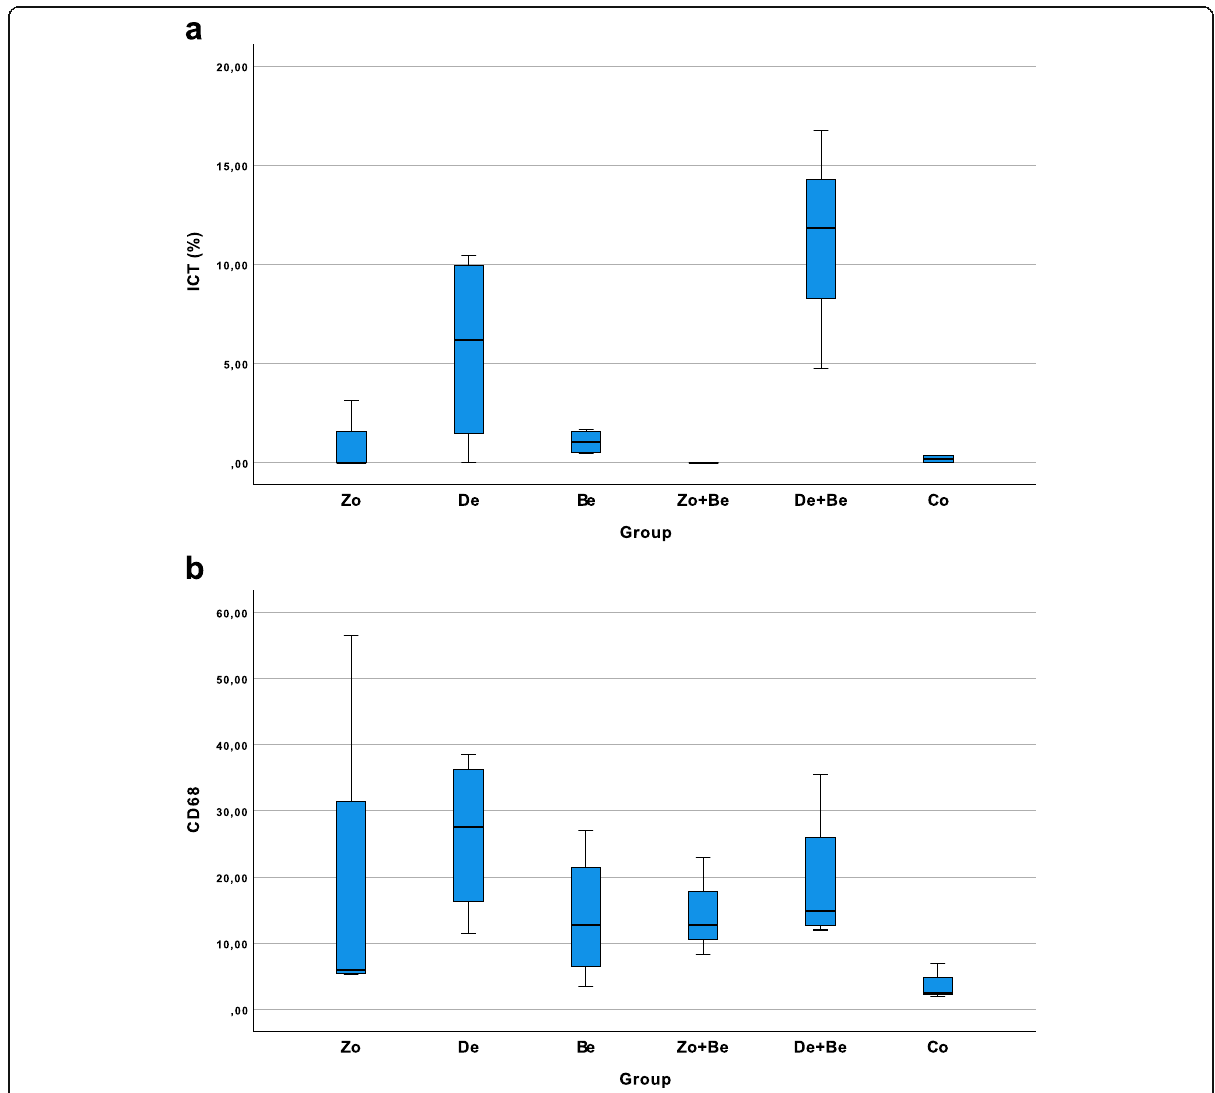
Fig. 5 Boxplots to depict the histomorphometrical analysis in different groups ( n =26 animals). a ICT% values. b CD68 counts. A significant difference was noted between De and Co groups ( P =0.029; unpaired t